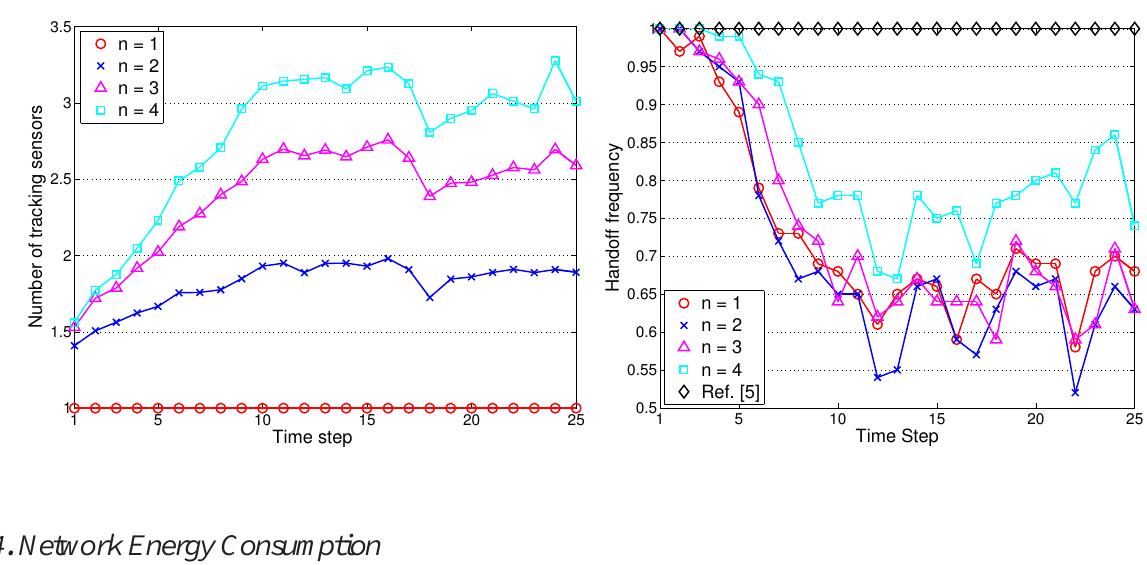
Figure 16. The typical runs of sub-cluster formation ( left ); the frequency of leader handoff ( right ).